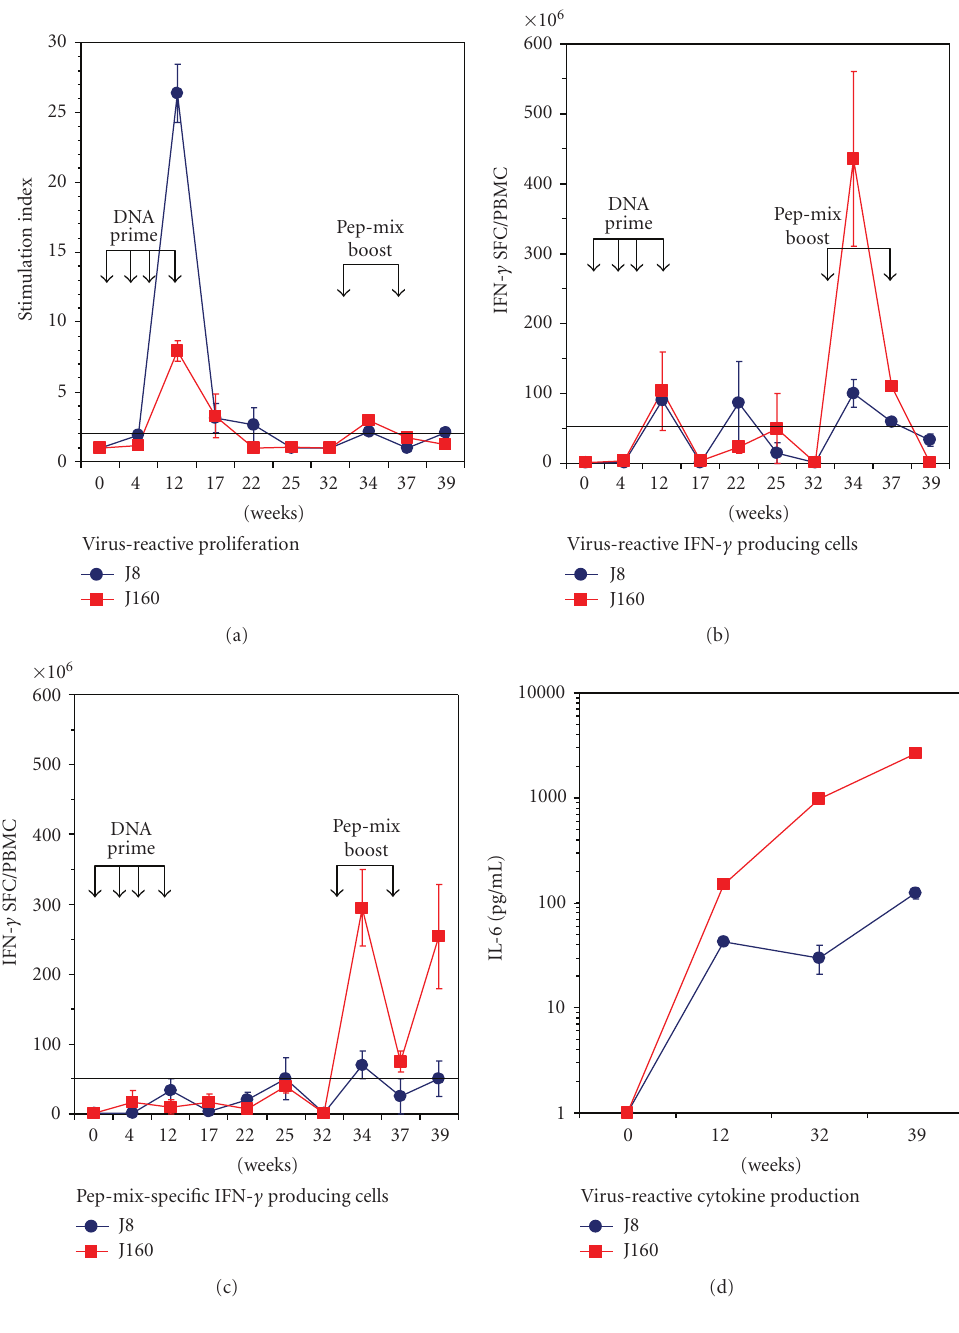
Figure 1: Immunization of rhesus macaques with plasmid DNA encoding MCP3-gp120 fusion primed viral-reactive T-cell immunity, which was further boosted by HIV-1 envelope peptide-cocktail vaccine. The DNA priming schedule included four rounds of immunization at 1- month intervals. Two rhesus macaques were immunized with 20 μ g of the plasmid DNA by gene gun injection at weeks 0, 4, 8, and 12. The boosting schedule included a peptide-cocktail vaccine that contains six highly conserved peptides from the HIV-1 envelope protein. After a rest period of 20 weeks following the final round of DNA vaccination to allow for the establishment of memory T cells, the peptide-cocktail boosts were administered by intranasal route along with a mutant cholera toxin on Weeks 32 and 37. Peripheral blood mononuclear cells collected after DNA vaccination revealed viral-reactive T-cell immunity as evidenced by the cell proliferation (a) and IFN- γ producing cells (b) in response to in vitro stimulation with cell-free, heat-inactivated SHIV 89 . 6P antigen-specific T-cell immunity was boosted by the peptide- cocktail vaccine, especially in #J160 showing significant elevation of IFN- γ producing cells in response to heat-inactivated SHIV 89 . 6P ) (b). The immunogenicity of the peptide vaccine was confirmed by analysis of peptide-specific T-cell immunity (c). Vaccine-induced cytokine production was examined using LINCOplex multiple cytokine luminescent assay. Among the cytokines assayed, IL-6 was predominantly detected in both macaques after DNA vaccination at Week 12. Virus-reactive IL-6 secretion was more apparent in monkey #J160, particularly during the period of peptide-cocktail